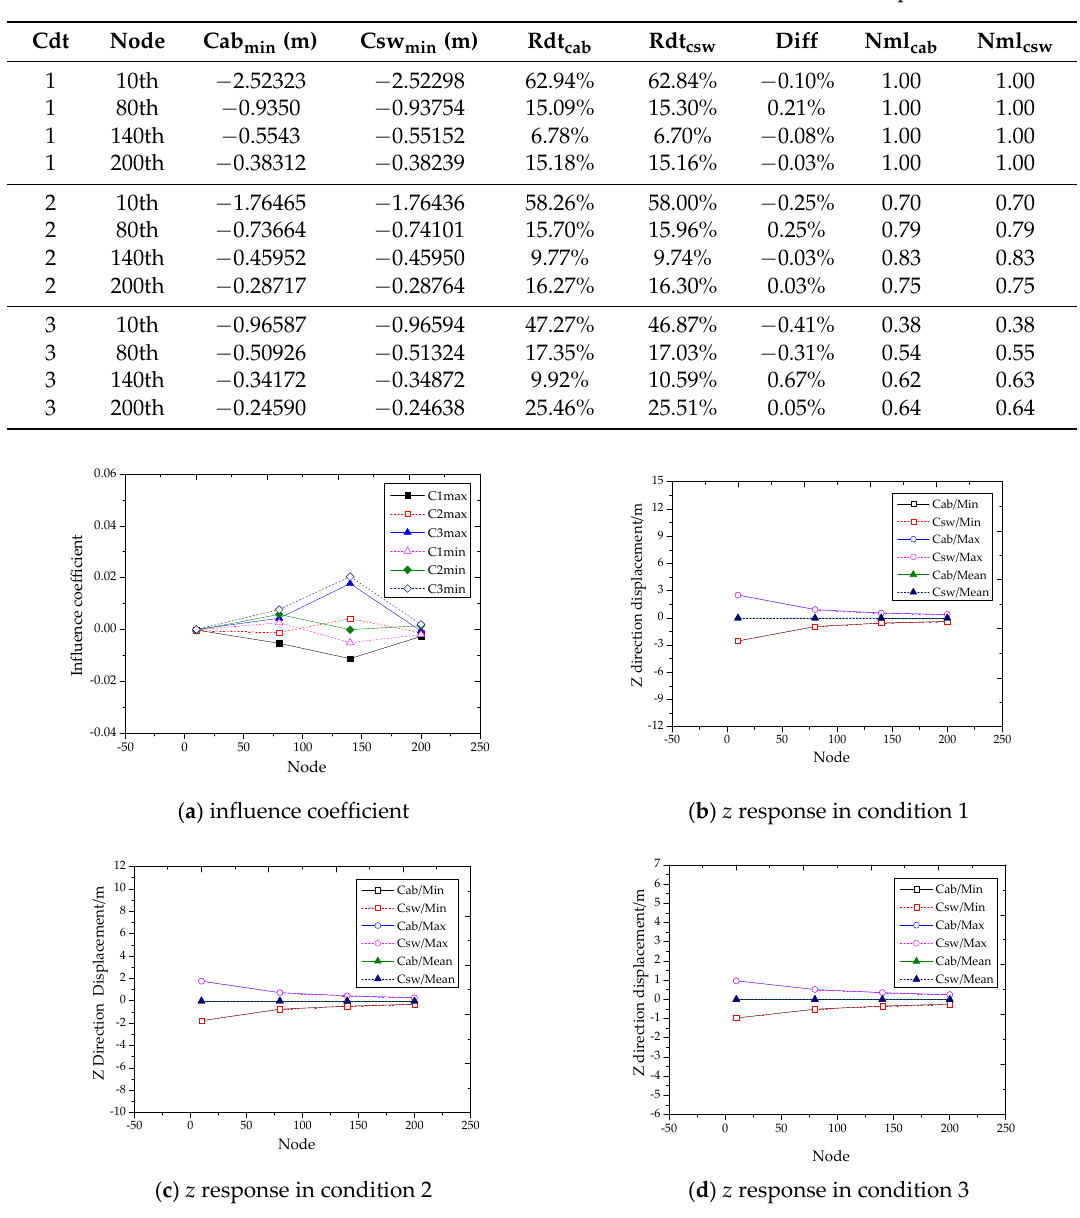
Figure 14. z -Direction response in conditions 1–3 changing with the nodes.